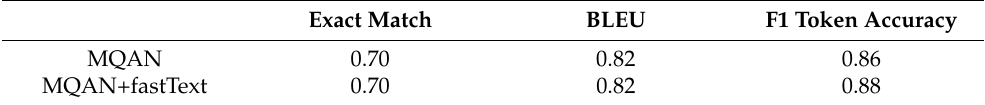
Table 6. Experiment results of the MQAN